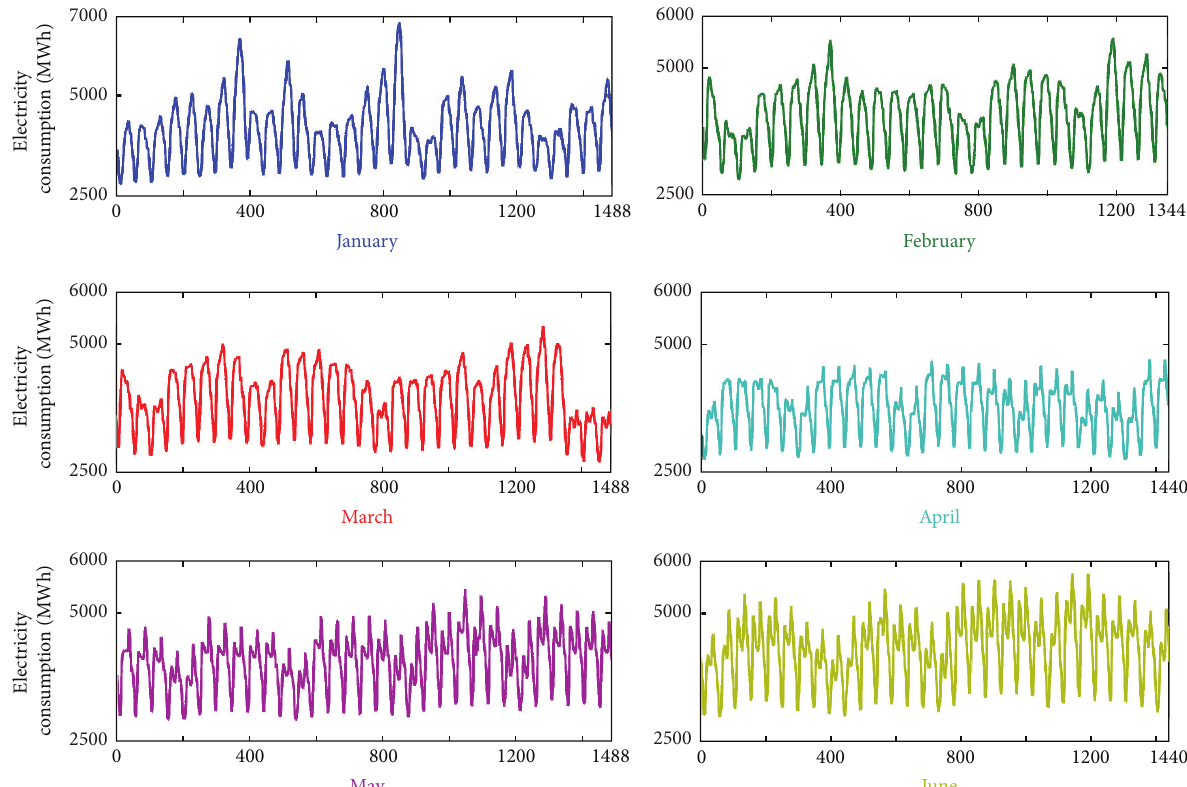
Figure 2: Electricity consumption data collected every 30 min in NSW from January 1st, 2013, to June 30th,